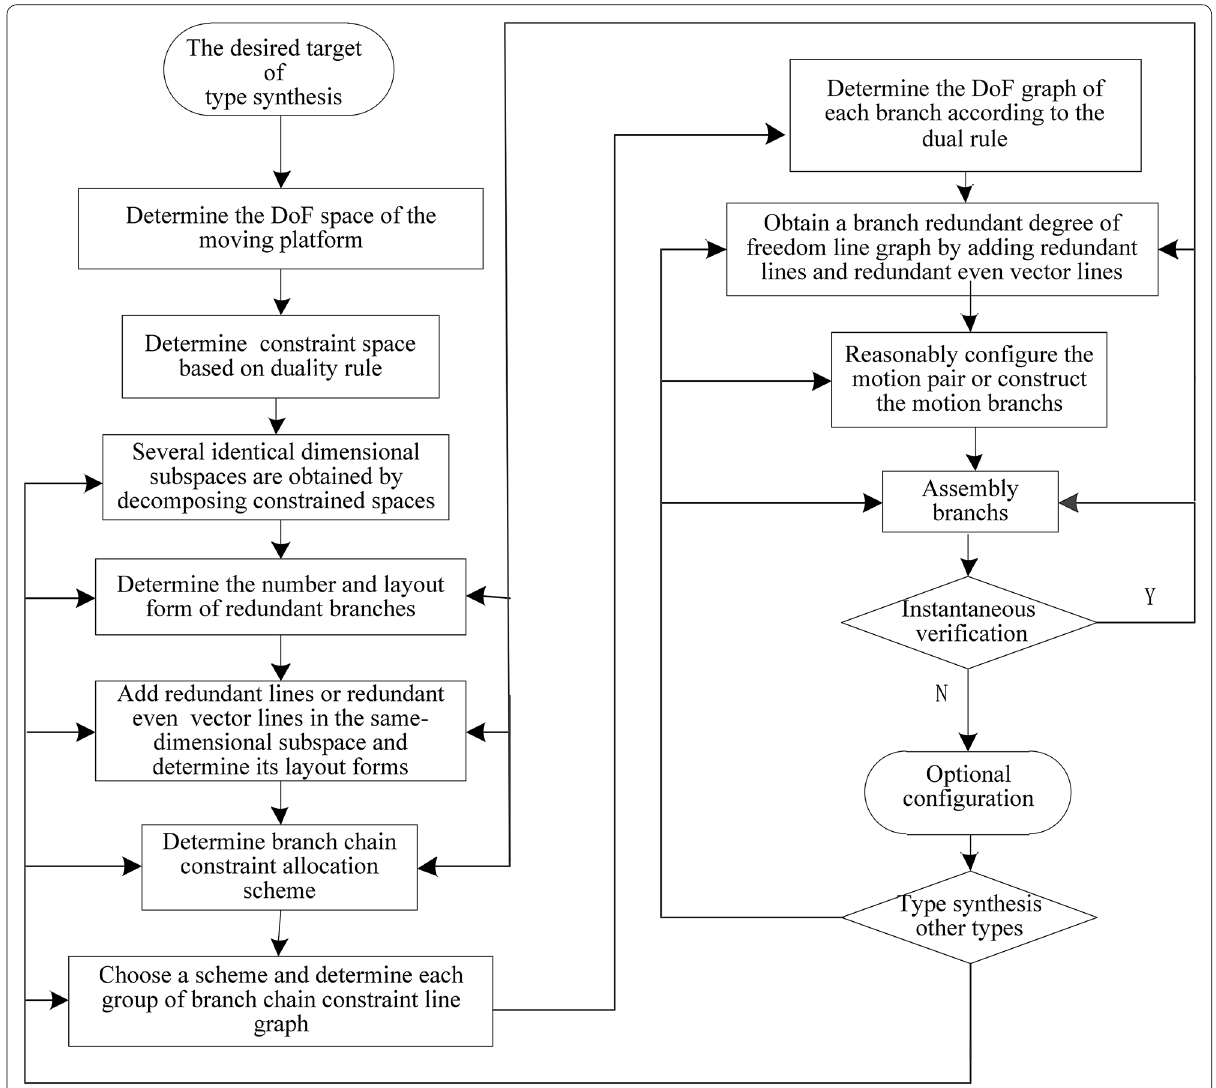
Figure 1 Type synthesis process diagram of redundant actuated parallel mechanisms